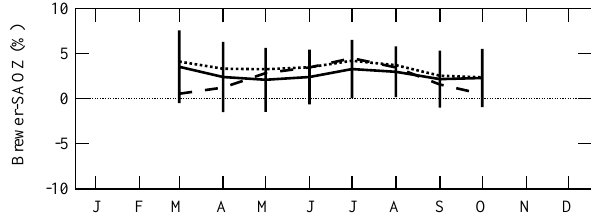
Fig. 9. Seasonal variation of the Brewer-SAOZ relative differ- ence at Sodankyla (dashed line: SAOZ V1, dotted line: SAOZ V2, solid line: Brewer corrected for temperature).